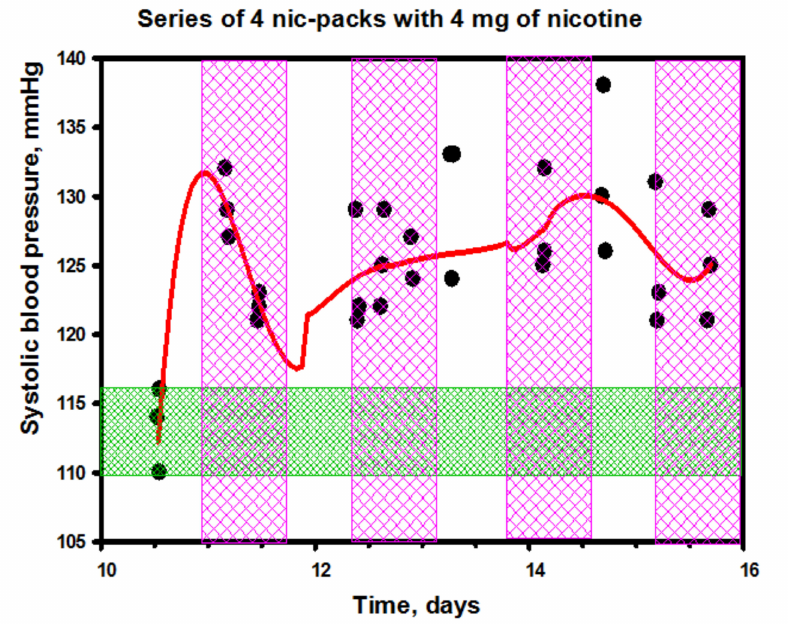
Figure 17. Changes in systolic blood pressure (SBP) during the period of nic-pack testing.